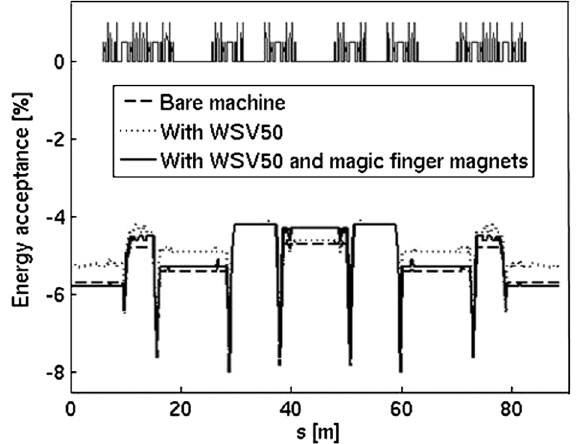
FIG. 4. Calculated variation of the negative energy acceptance alongonesuperperiod(onefourthofthestoragering).Calculations are performed with TRACY II .